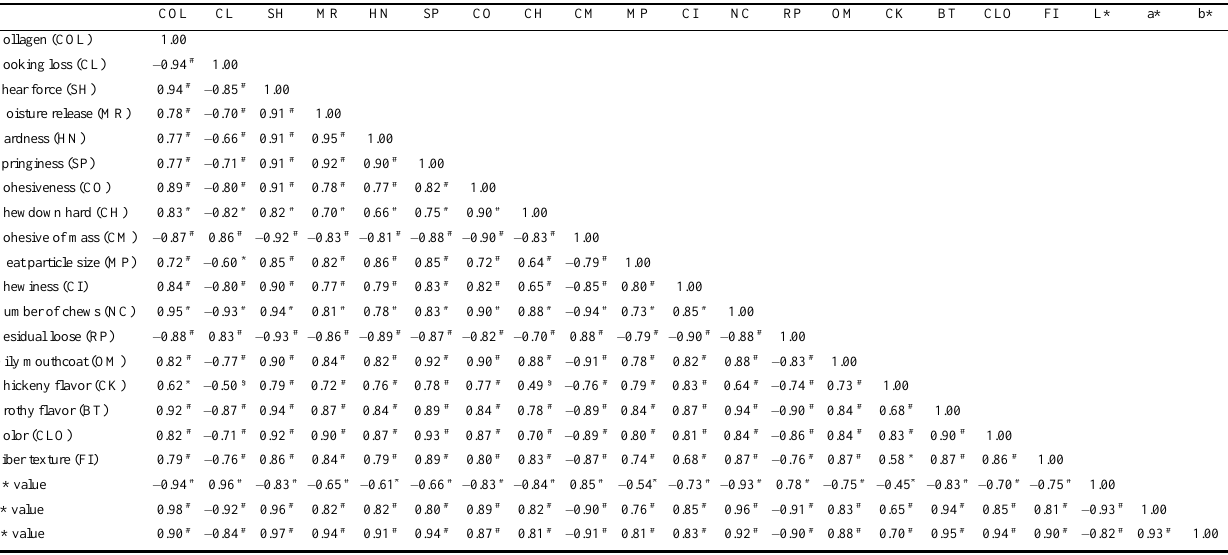
Table 4. Pearson correlations between descriptive sensory attributes and instrumental analysis in broiler breast meat